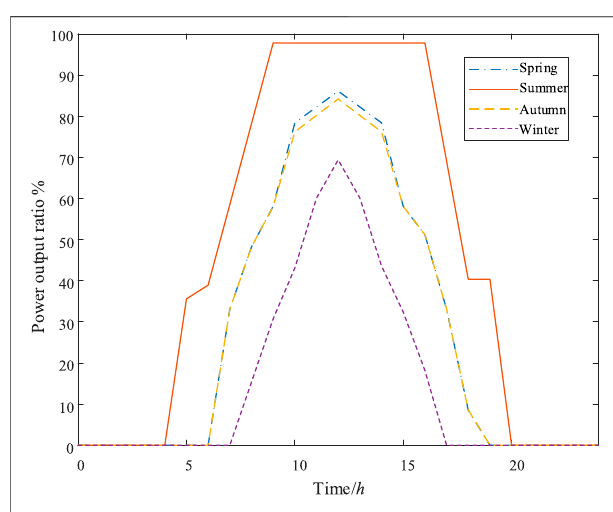
FIGURE 2 | Annual output curve of PV system.